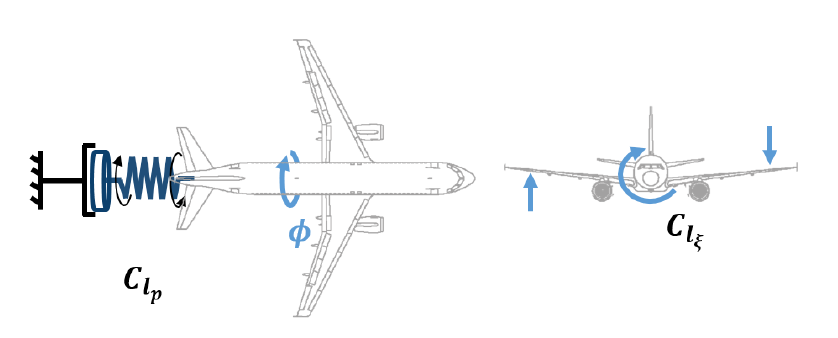
Figure 5. Illustrations of equivalent mass–spring–damper roll